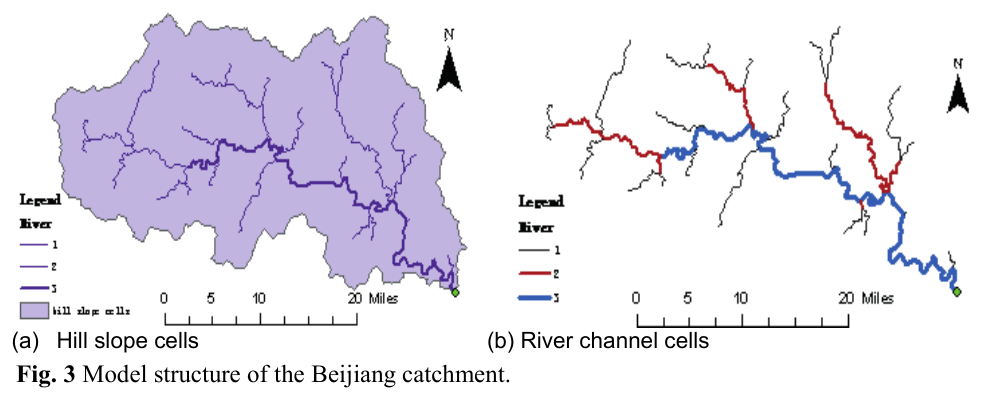
Fig. 3 Model structure of the Beijiang catchment.